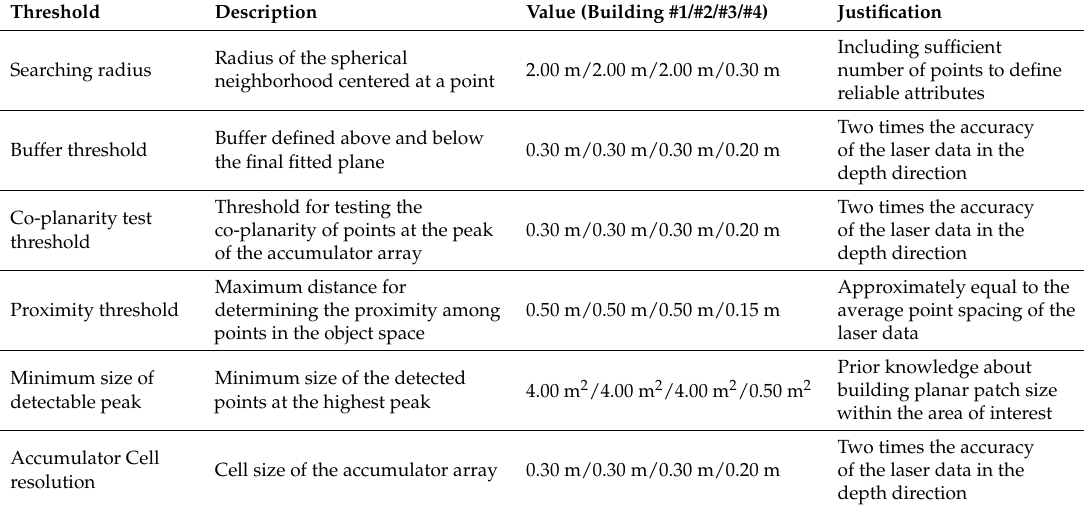
Table 3. Descriptions, values, and justifications for the thresholds used in the segmentation